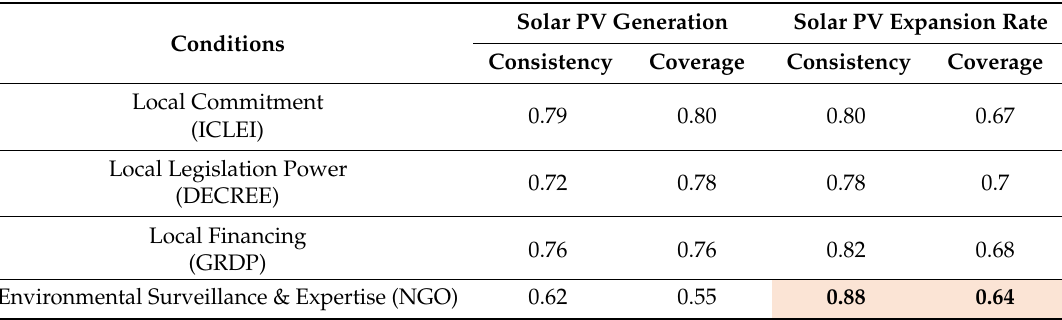
Table 2. Analysis of necessary